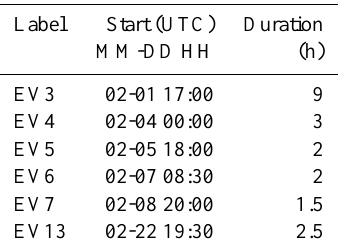
Figure 3. Summary characteristics of the six cases where riming is identified as the dominant mechanism (as listed in Table 2). (a) Mean snowfall accumulation intensity measured at MAE. The red number on top of each bar indicates the duration of the rimed time period. The numbers on the right side of the bars are the closest quantiles of the distribution of all snowfall events of the same du- ration in the same location (data from 2000 to 2014). The letters C and E refer to cases indicated in the text as “core” and “edge”, respectively. The blue line indicates the mean value (during precip- itation only) of CLACE 2014. (b) Average vertical profile of the percentage of rimed precipitation PRP (%) during the selected time periods. Table 2. List of the six rimed phases, subset of the events of Table 1, during which rimed precipitation was dominant according to the radar-based GTB2015